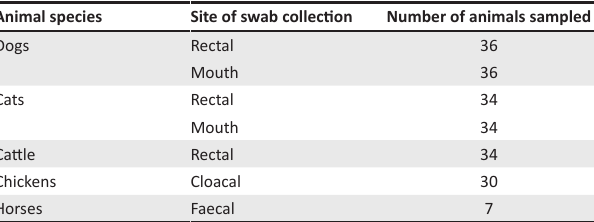
TABLE 1: Distribution of samples based on animal species and site of swab collection. Animal species Site of swab